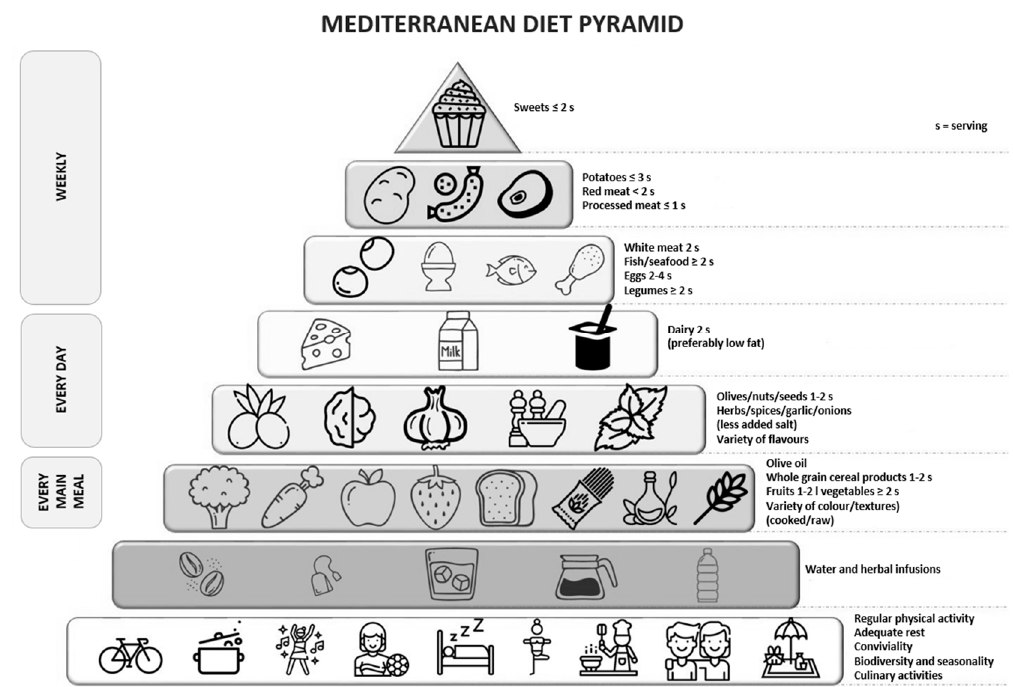
Figure 1. Mediterranean diet pyramid. Source: own study based on [40].